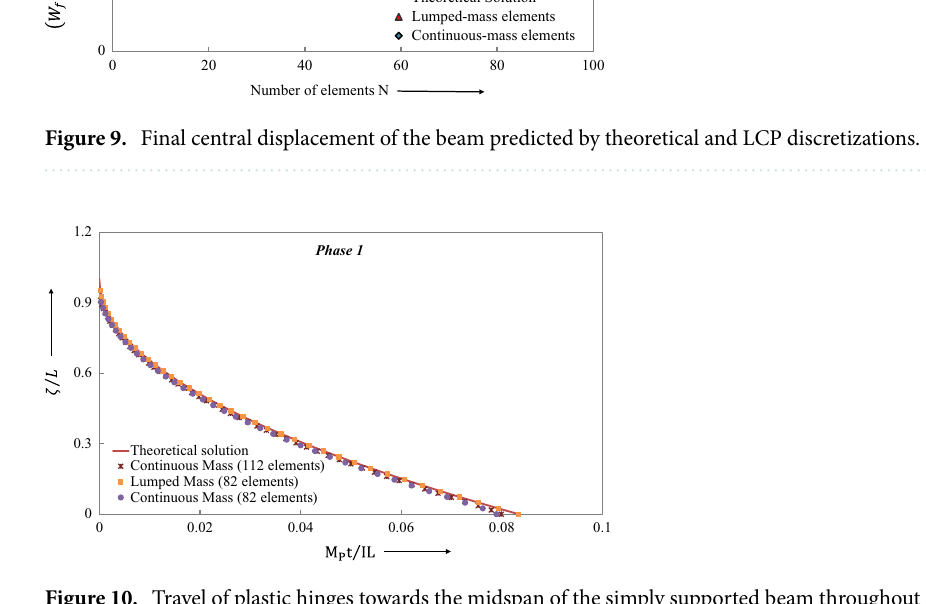
Figure 10. Travel of plastic hinges towards the midspan of the simply supported beam throughout Phase 1predicted by different